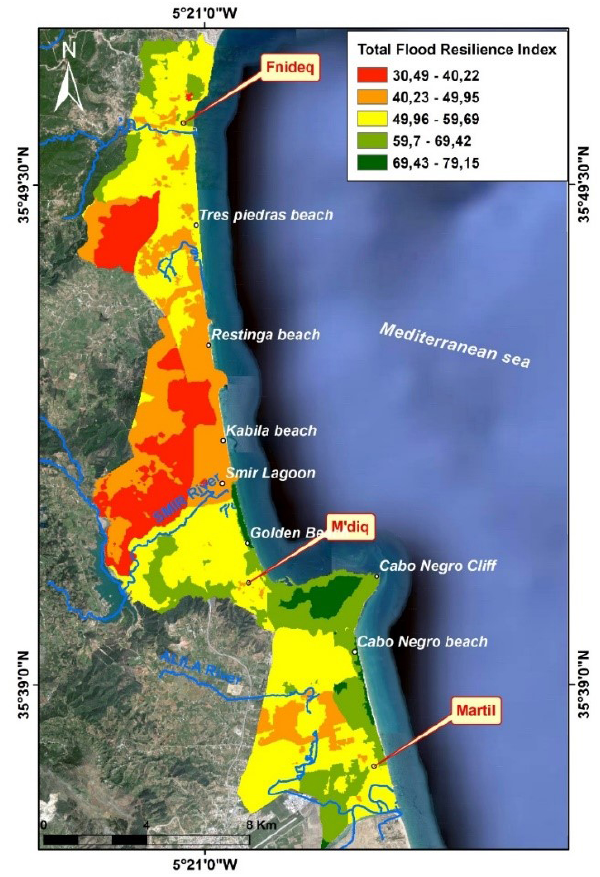
Figure 7. Distribution of total flood resilience index (obtained from © Google Maps 2018). Table 2. Spearman’s rho correlation between the total flood re- silience index (FRI) and its dimensions.